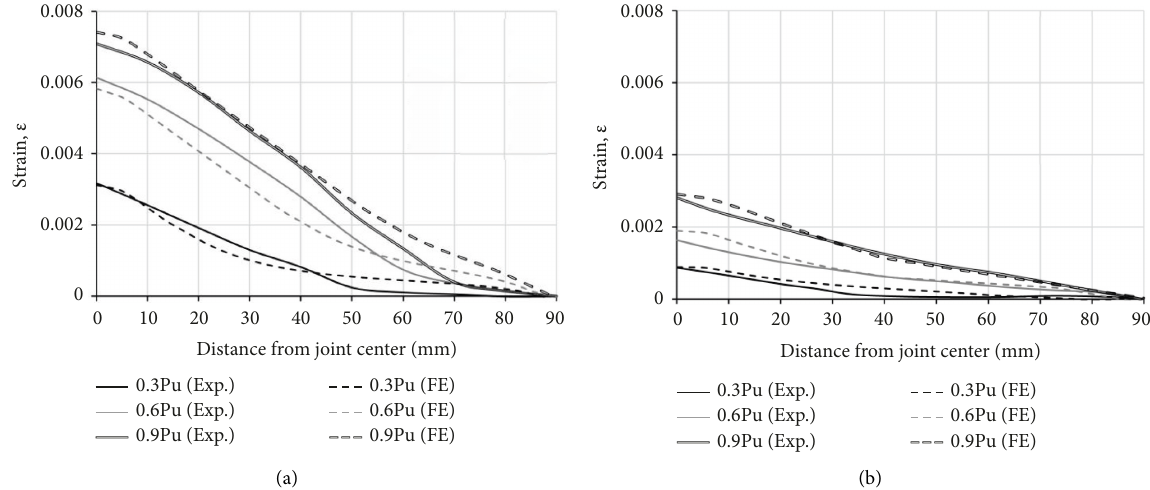
Figure 11: CFRP strains along the bond length (from the centre of joint to free end) for specimens. (a) NS-90 and (b) UHS-90.